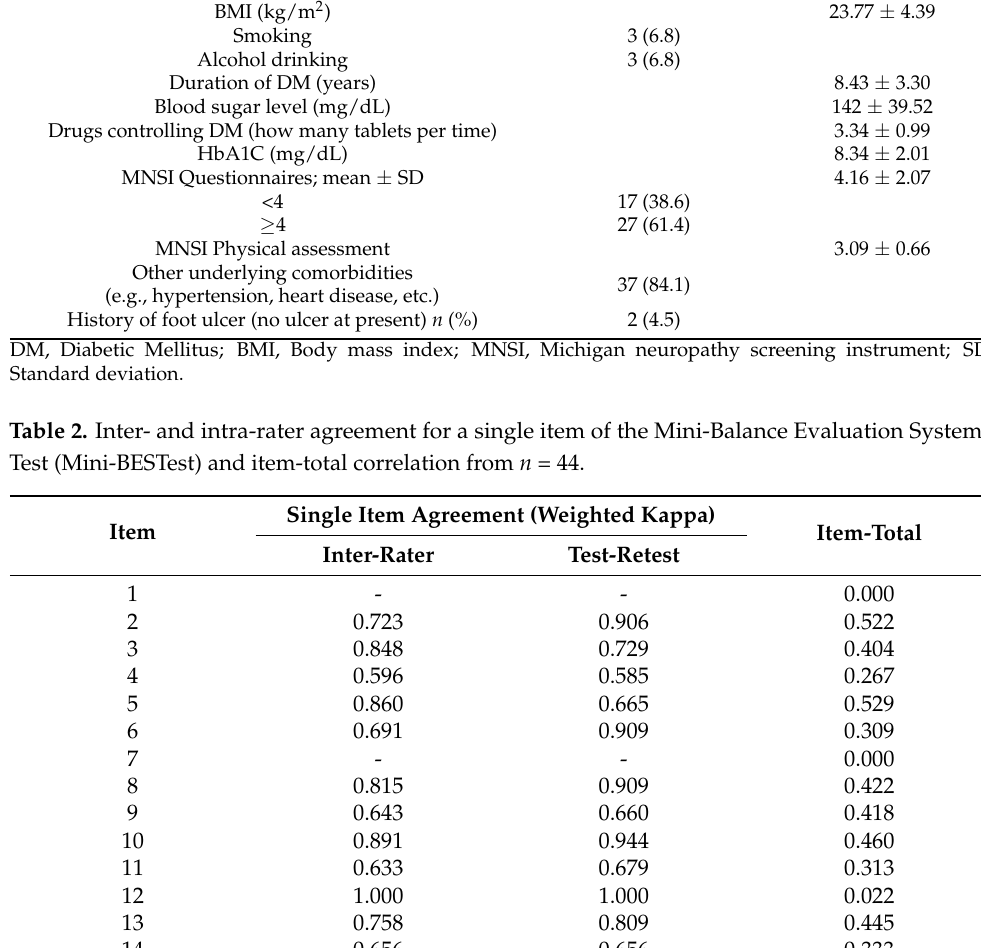
Table 4 reveals the mean difference of Mini-BESTest scores between the participants reporting MNSI questionnaire scores ≥ 4 and <4 was 2.09 (95% CI = 0.52 to 3.66 ±